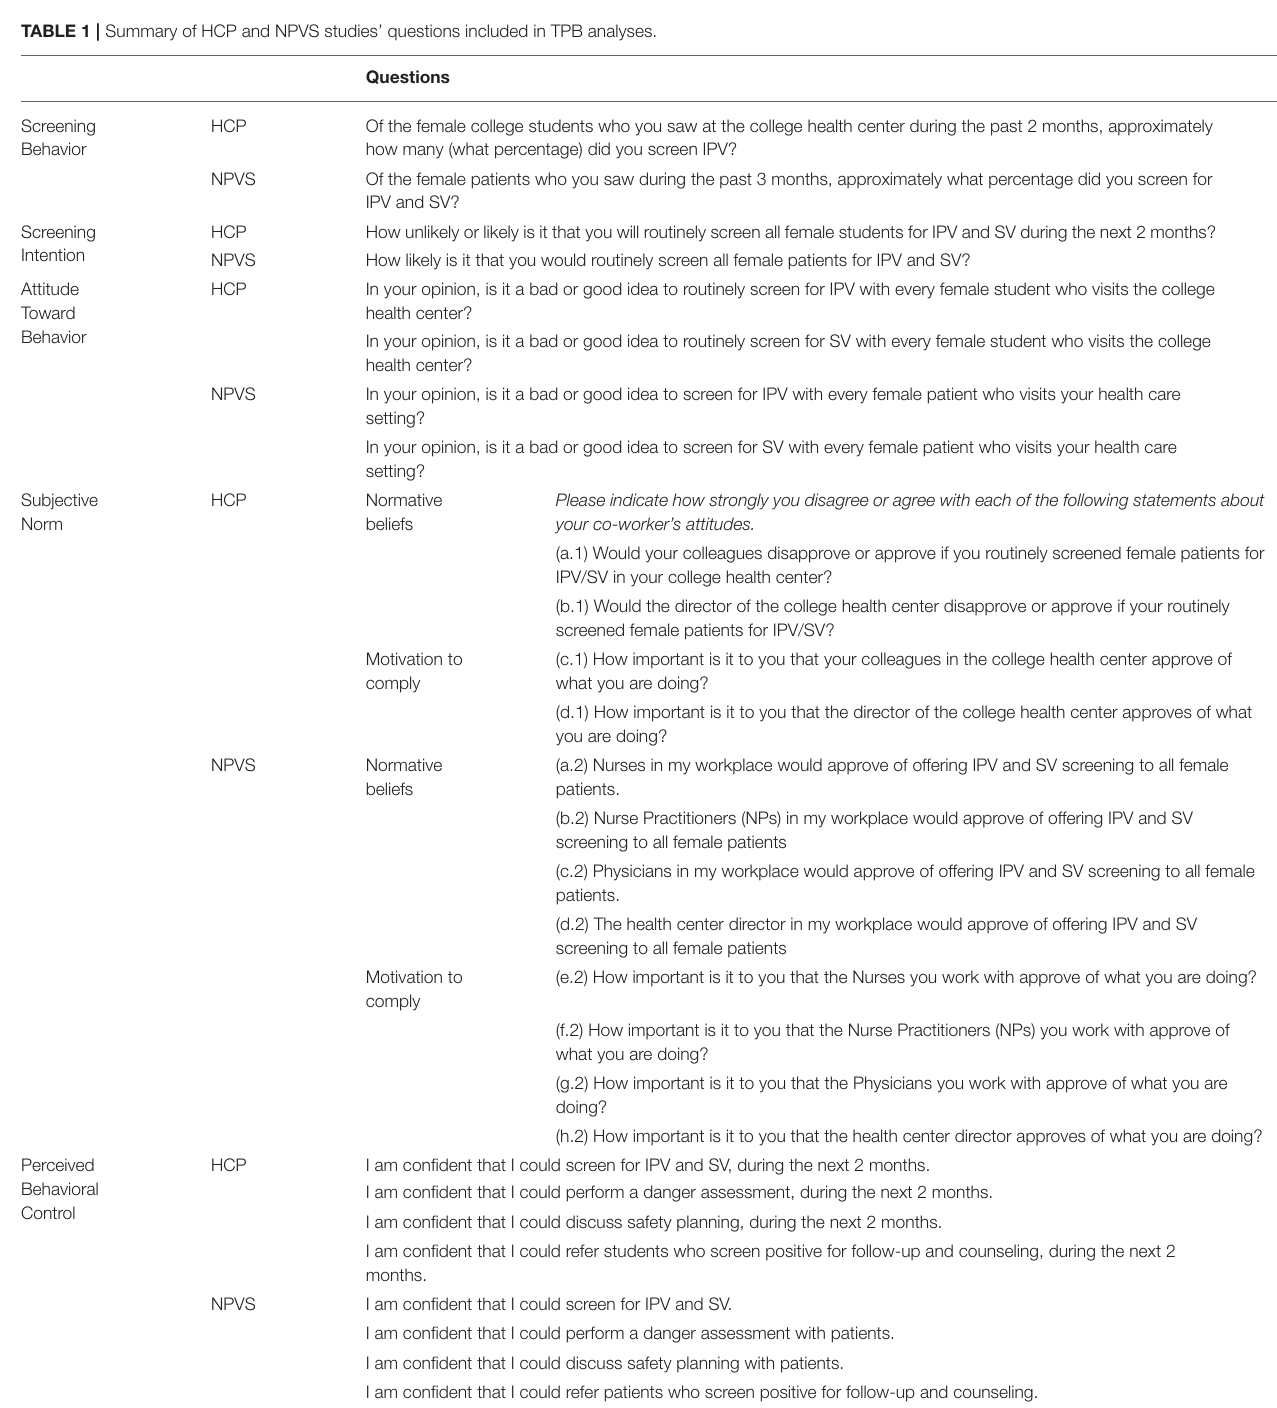
TABLE 1 | Summary of HCP and NPVS studies’ questions included in TPB